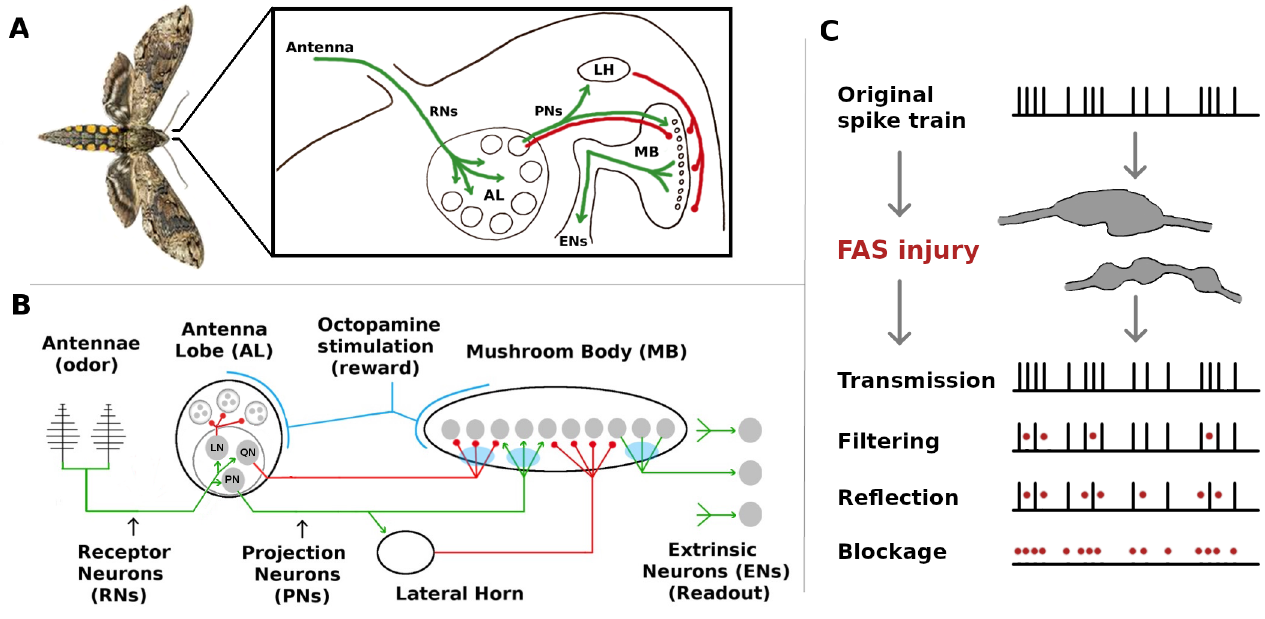
Figure 1. Overview of the Moth Olfactory Network (MON) and axonal injury mechanisms. ( A , B ): The MON is organized as a feedforward cascade of three distinct subnetworks and a reward mechanism [10,11]. For a brief summary of the MON, see Section 5.1. For full details, see [7]. ( C ) Focal Axonal Swellings (FAS) are ubiquitous across all severities of traumatic brain injuries and present in other leading brain disorders. They can cause some or all neural spikes in the train to die off in transit, reducing the overall firing rate arriving at the downstream target neuron. Adding FAS-like effects to the MON are the basis of our damage/injury protocols. See Section 5 for